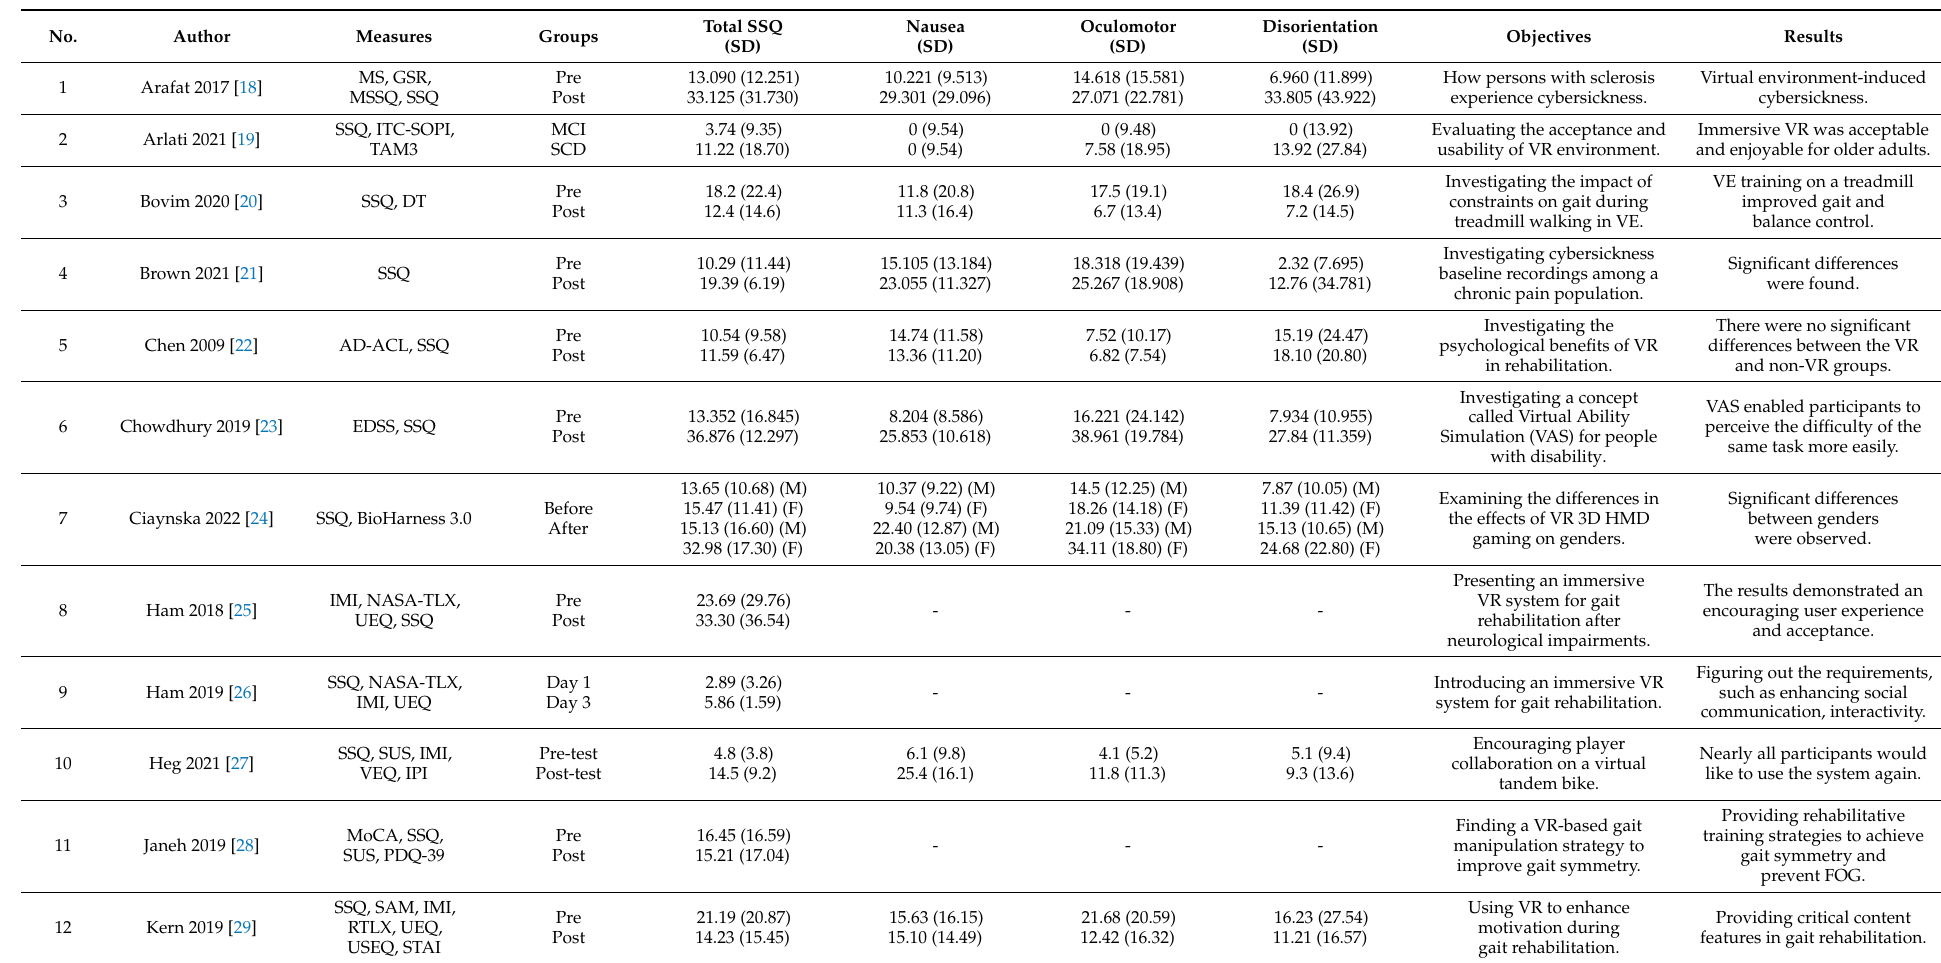
Table 3. Summary of included papers.